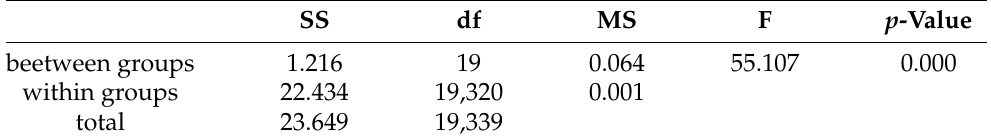
Table 3. ANOVA analysis of the channel-wise attention weights in the EE estimation. SS is the sum of squares, df is the degree of freedom, MS is the mean square, and F is the F-statistic.